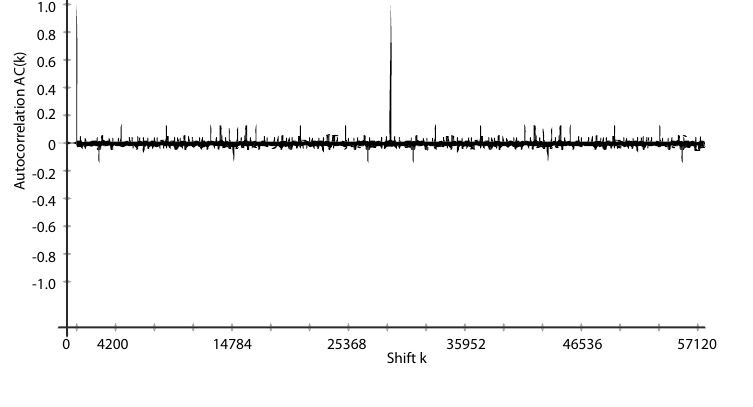
Figure 6. Autocorrelation of a sequence generated with n = 16 , m = 8 and l = 15